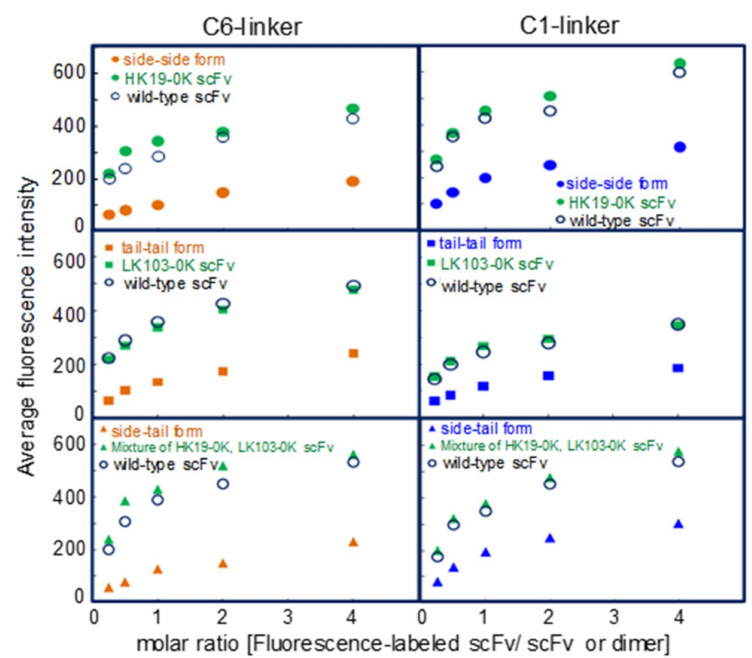
Figure 7. Competitive binding assay of non-labeled scFv, HK19-0K or LK103-0K scFv, side–side dimers with C1 and C6 linkers, side–tail dimers, and tail–tail dimers with C1 and C6 linkers, with FITC-labeled wild-type scFv. 10 6 A431 cells were mixed with the non-labeled scFv or dimer (50 pmol), washed, and various amounts of fluorescently labeled wild-type scFv were added.